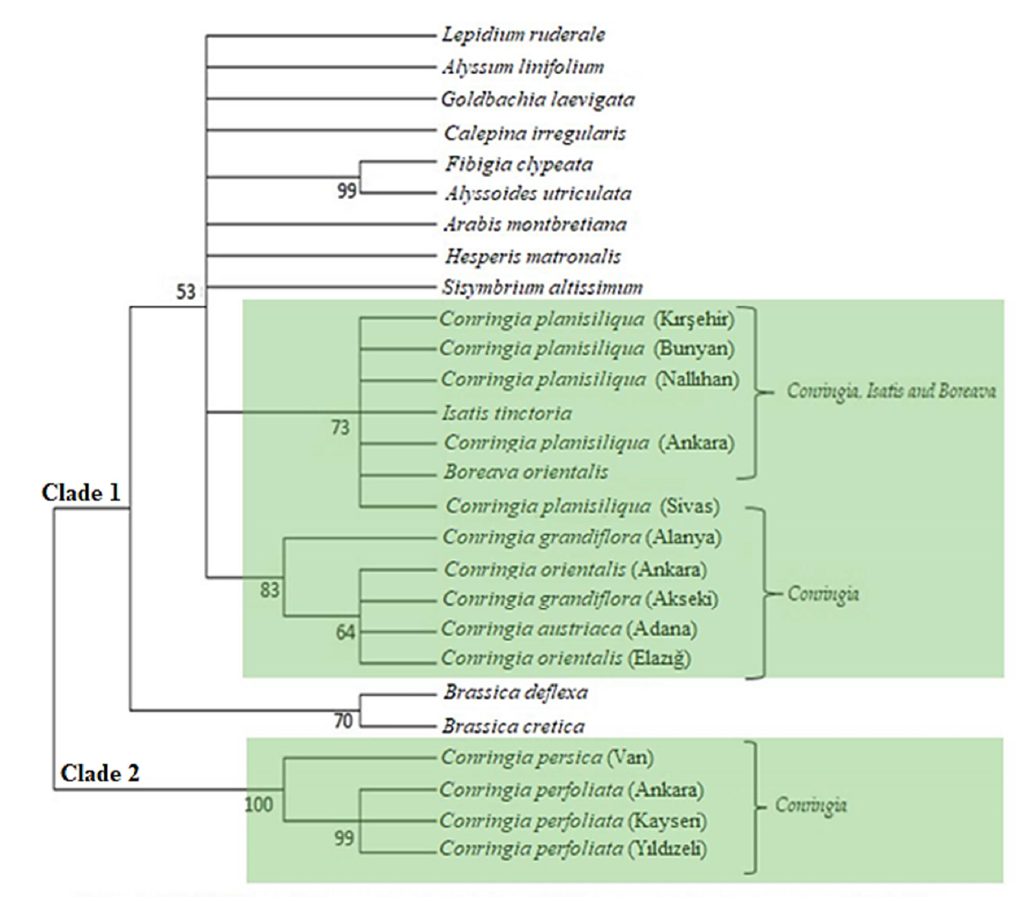
Figure 4. The Neighbor joining tree generated using trn L-F sequences Conringia genus and